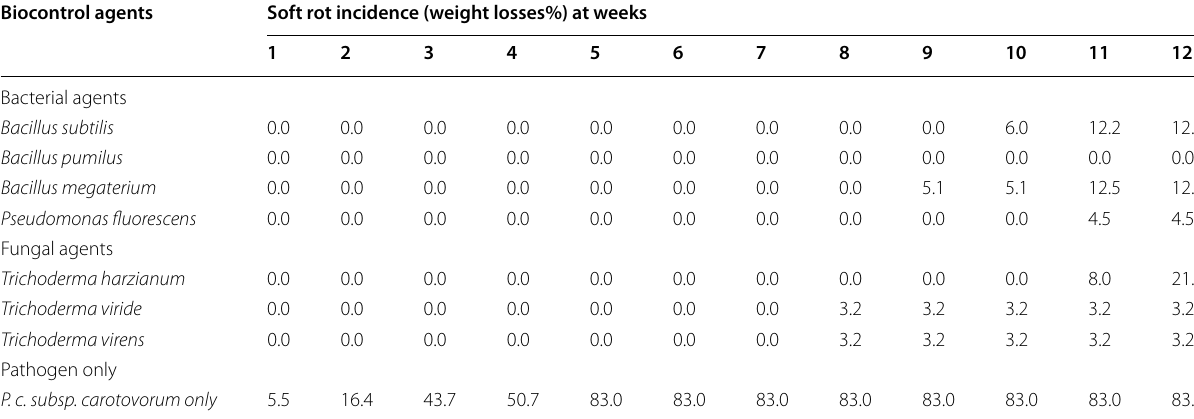
Table 5 Inhibitory activity of biocontrol agents against incidence of bacterial soft rot disease on potato tubers when artificially inoculated in vivo